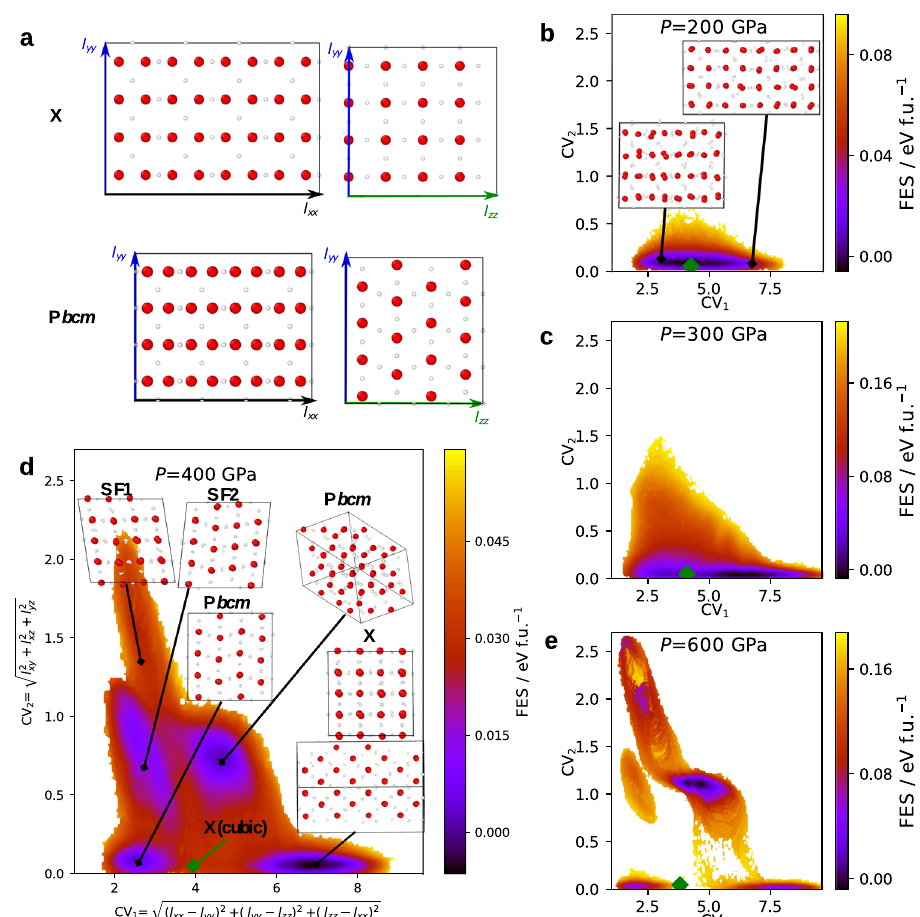
Fig.3|FreeenergyoftheX – P bcm transition.a Con fi gurationsofP bcm andX.The orthorhombic simulation cell contains 64 water molecules and is commensurate with both the X and the P bcm structures. Free-energy surfaces (FES) at b 200GPa, c 300GPa, d 400GPa and e 600GPa, all computed at 1000K, asa function of two collective variables: CV 1 measures the anistropy of the box and CV 2 measures the